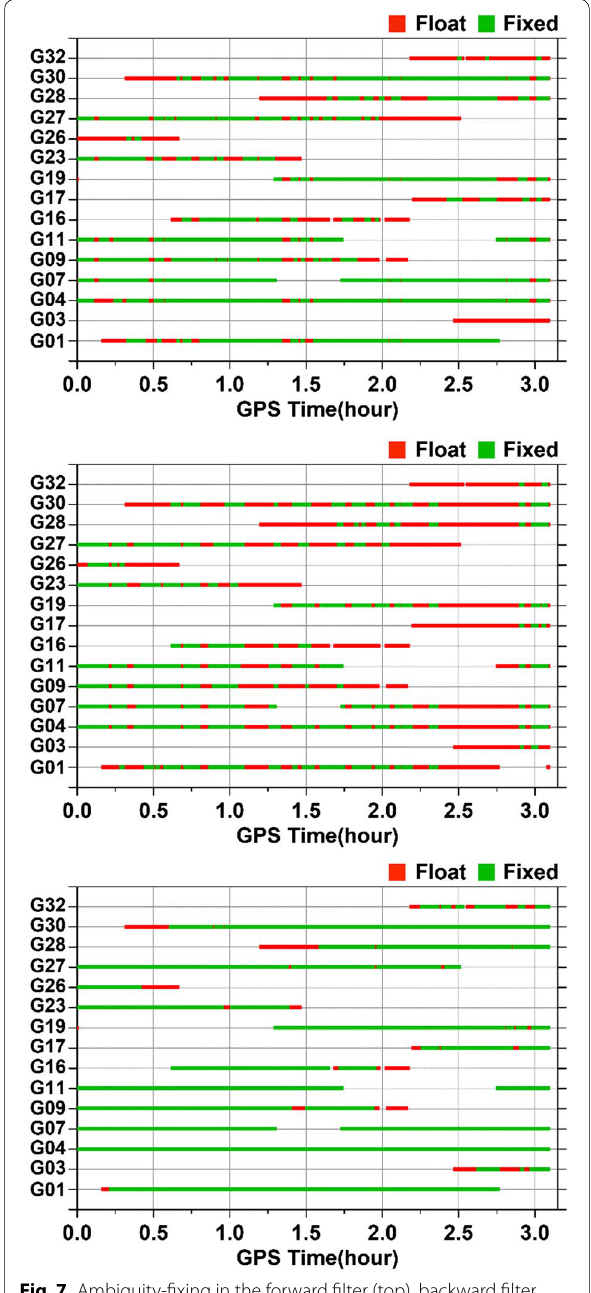
Fig. 7 Ambiguity-fixing in the forward filter (top), backward filter (middle) and the ADBI method (bottom) for vehicular data. The red curve denotes the float ambiguity results and the green means the fixed ambiguity